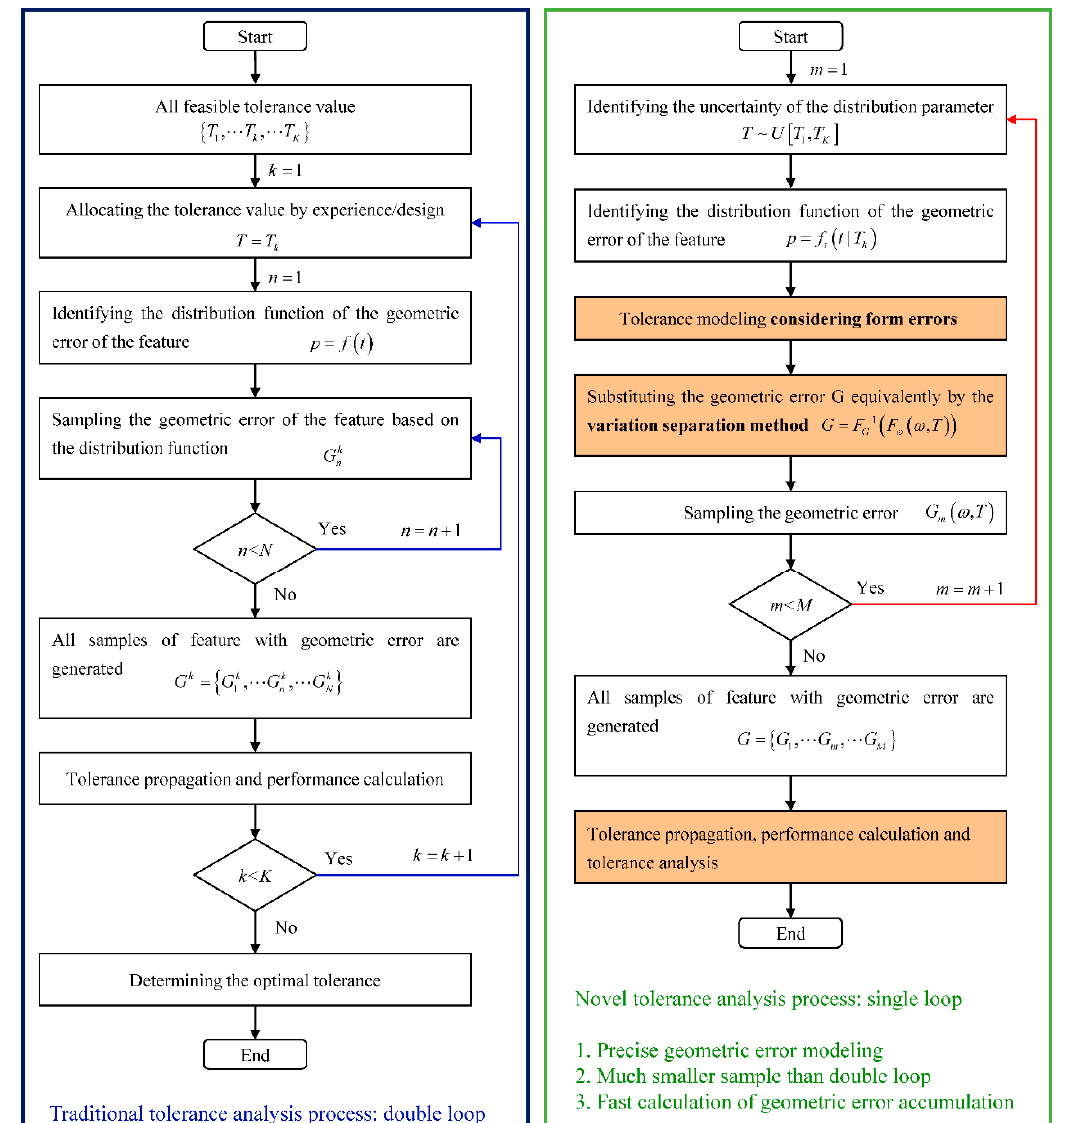
Figure 3. The process of the tolerance analysis. The left part shows the traditional tolerance analysis process, and the right part shows the novel tolerance analysis process.